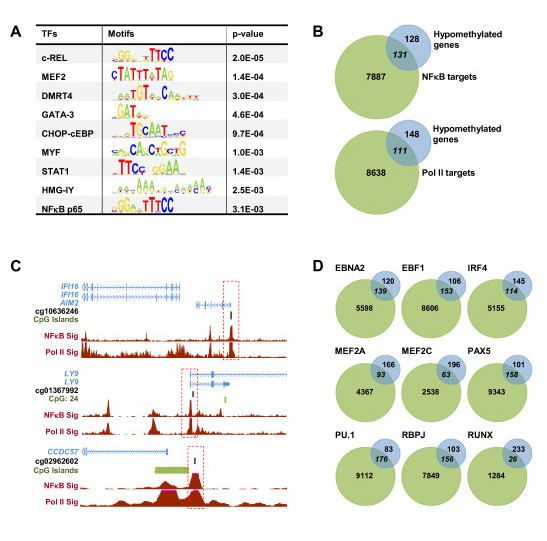
Association of factors with hypomethylation during RBL to LCL conversion. (a) Significant enrichment of predicted transcription factors (TFs; TRANSFAC motif) in hypomethylated regions. The 500-bp region around the center of significantly hypomethylated CpG sites was tested. Color intensity in the heatmap cells represents FDR P-values. Redder and yellower colors indicate greater and lower significance, respectively; gray indicates insignificance. (b) Venn diagram showing overlap of NF-κB targets from ChIPseq (considering targets that are also within the hypomethylated list) and hypomethylated genes (the 131 overlapping genes are listed in Additional file 4). (c) Three examples showing NF-κB p65 binding to the region neighboring the hypomethylated CpGs. The binding motif location is presented as a horizontal green bar. Below, NF-κB p65 and RNA polymerase II (Pol II) binding from GM12878 ChIP-seq data are shown. (d) Venn diagrams showing overlap between hypomethylated genes and transcription factors EBF1, IRF4, MEF2A, MEF2C, PAX5, PU.1, RBPJ, RUNX and EBNA2.